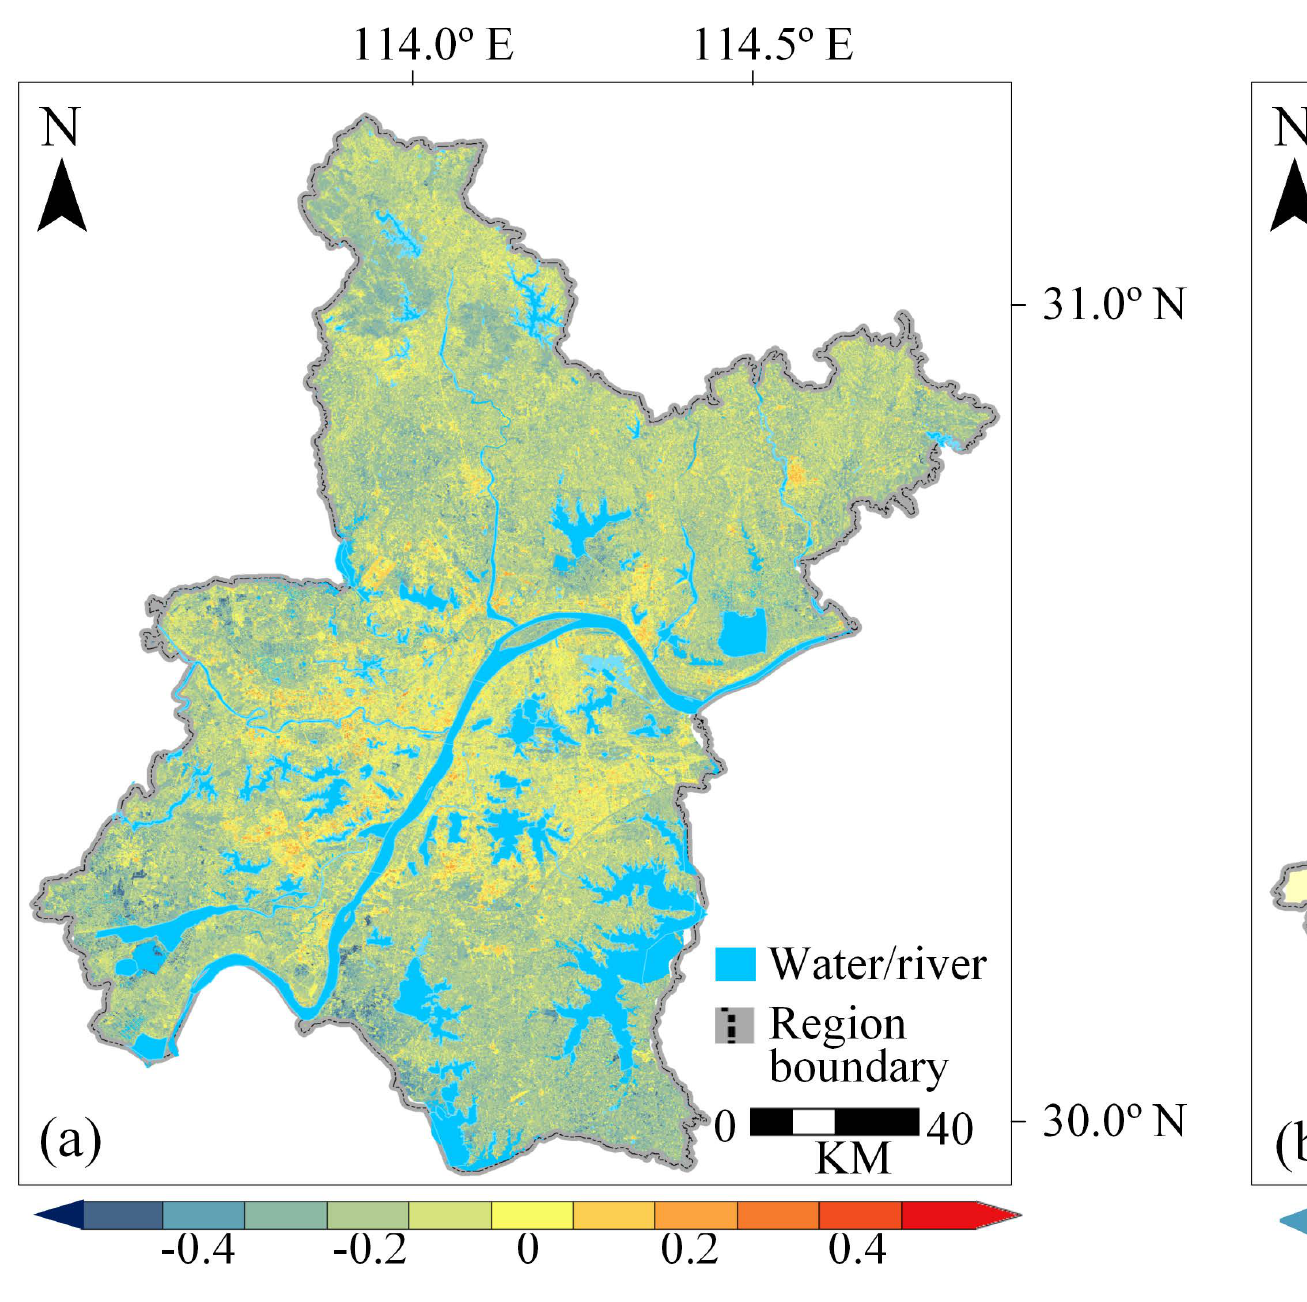
Figure 7. Distribution of NDBI ( a ) and its coe ffi cient for percentage of landscape (PLAND, ( b ) and aggregation index (AI, ( c )) from geographically weighted regression